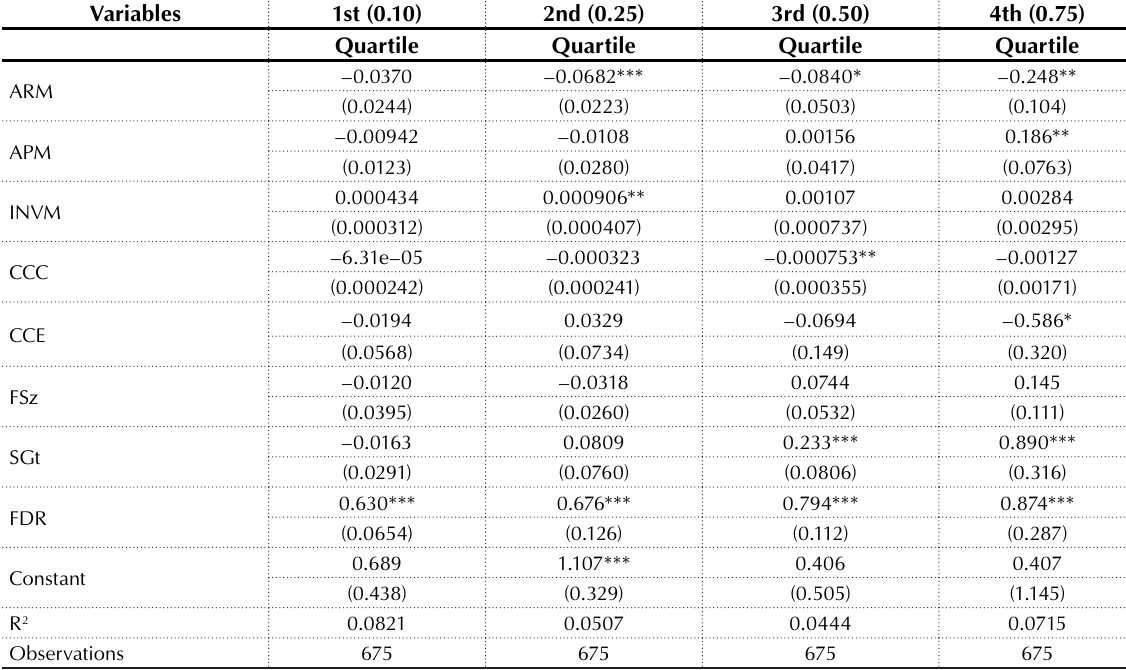
Table 8. Result of quantile regression (QR) for the TQ model